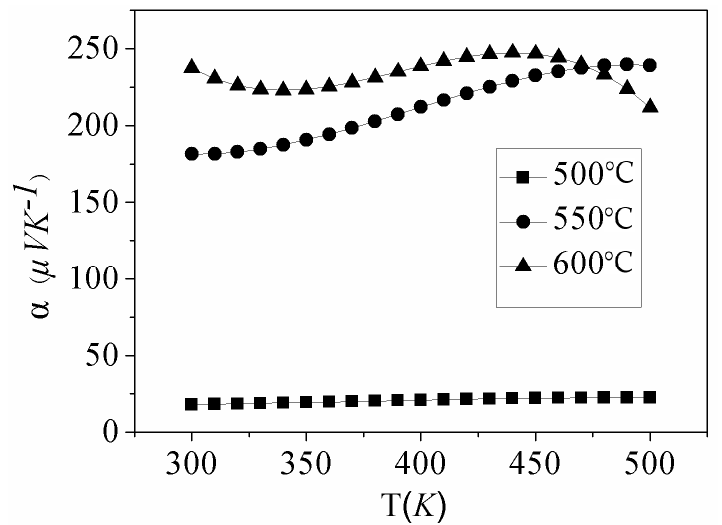
Figure 6. Seebeck coefficient as a function of temperature for (Bi 0.48 Sb 1.52 )Te 3 thick films.